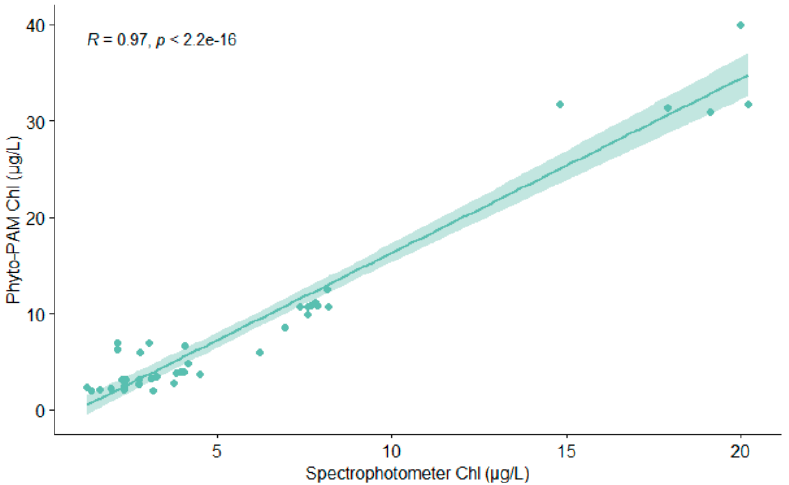
Figure 3. Correlation plot between Phyto-PAM-measured Chl concentration and spectrophotometric measurements (with confidence bands).